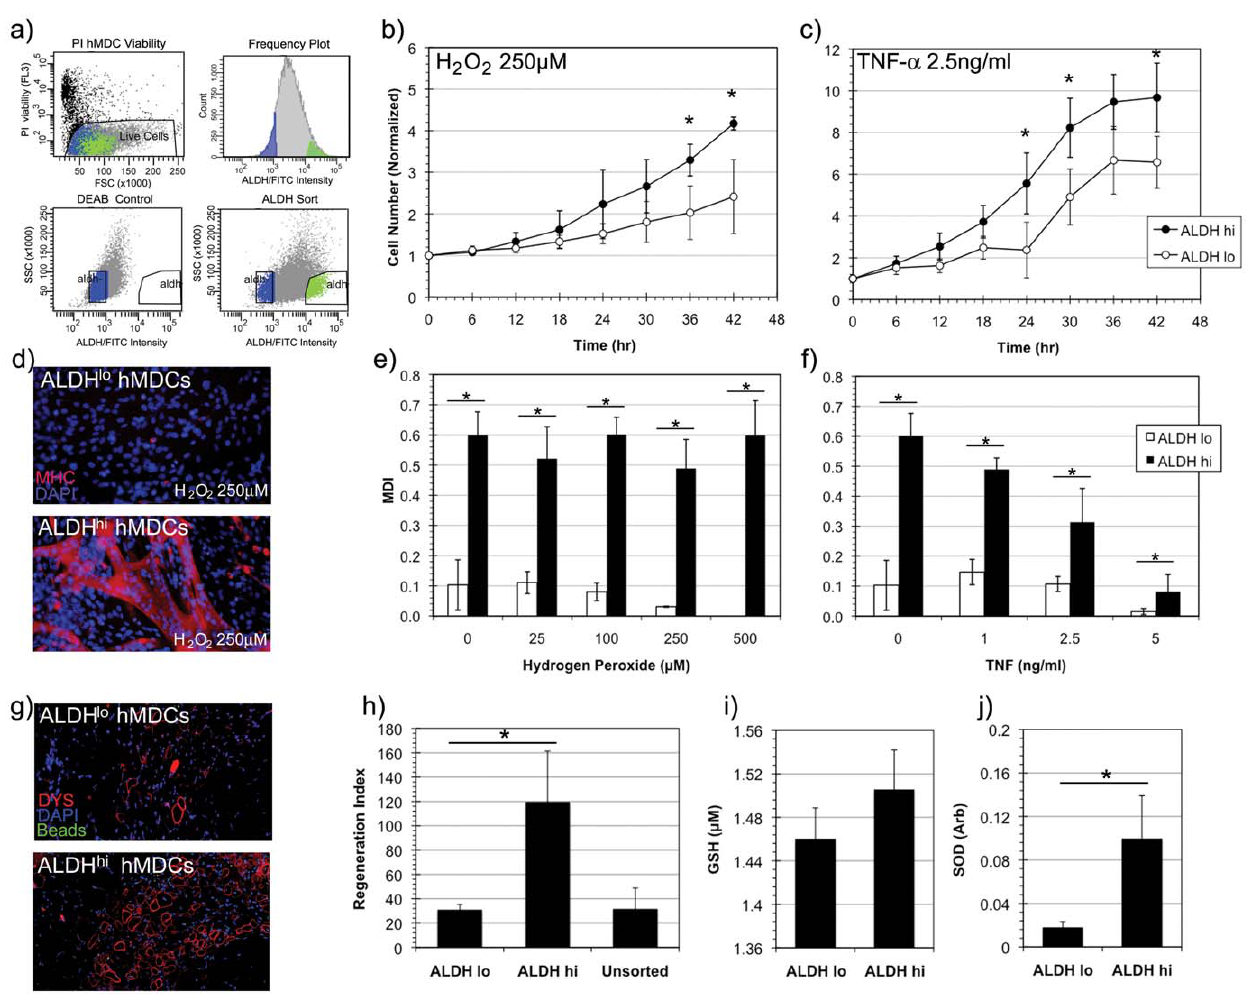
Figure 6. Isolation and stress resistance capacity of ALDH hi human muscle derived cells (hMDCs). (a) ALDH hi hMDCs were isolated using FACS. (b, c) Significantly increased rates of proliferation of ALDH hi hMDCs compared to ALDH lo hMDCs were observed in conditions of oxidative (H 2 O 2 , 250 m M) and inflammatory stress (TNF- a , 2.5 ng/ml) (n=6, * indicates p , 0.05). (d) Myogenic differentiation capacity was measured in low serum conditions by myosin heavy chain (MHC, shown in red) expression. ALDH hi hMDCs generated dense networks of MHC + myotubes in oxidative stress conditions (H 2 O 2 , 250 m M) in contrast to ALDH lo hMDCs. (e, f) Significantly increased myogenic differentiation indices (MDI) were calculated in ALDH hi hMDCs in oxidative (H 2 O 2 ) and inflammatory (TNF- a ) stress conditions compared to ALDH lo hMDCs. (g, h) Dystrophin (DYS, red) positive myofiber regeneration was observed following intramuscular injection of ALDH sorted hMDCs. A significantly increased regeneration index was observed in ALDH hi hMDC transplanted mdx /SCID mice compared to those injected with ALDH lo and unsorted hMDCs (n=3). (i) While a trend of increased GSH levels was observed between ALDH hi and ALDH lo hMDCs, this increase was not statistically significant. (j) However, significantly increased superoxide dismutase (SOD) activity was observed in ALDH hi hMDCs when compared to ALDH lo hMDCs